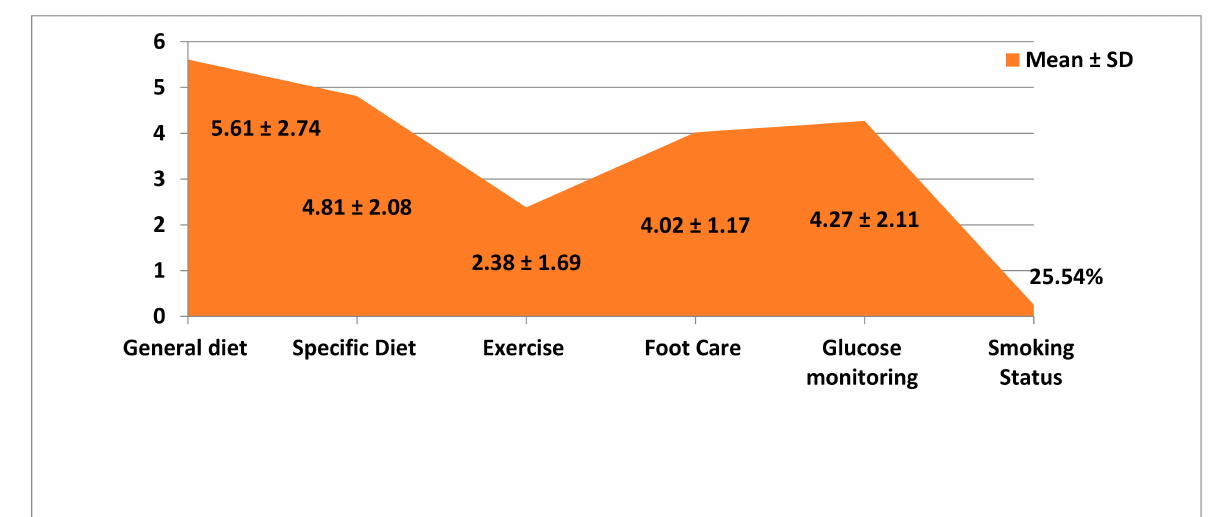
Figure 1. Mean ± SD of Self-Care Behavior of the T2D patients.